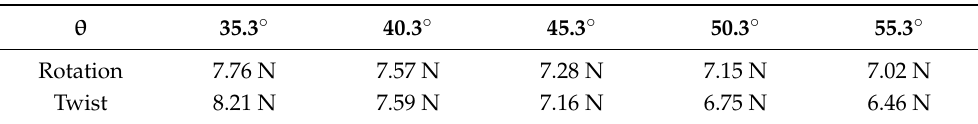
Table 1. The simulation results of the reaction force in both rotating and twisting directions with respect to different intersection angles.